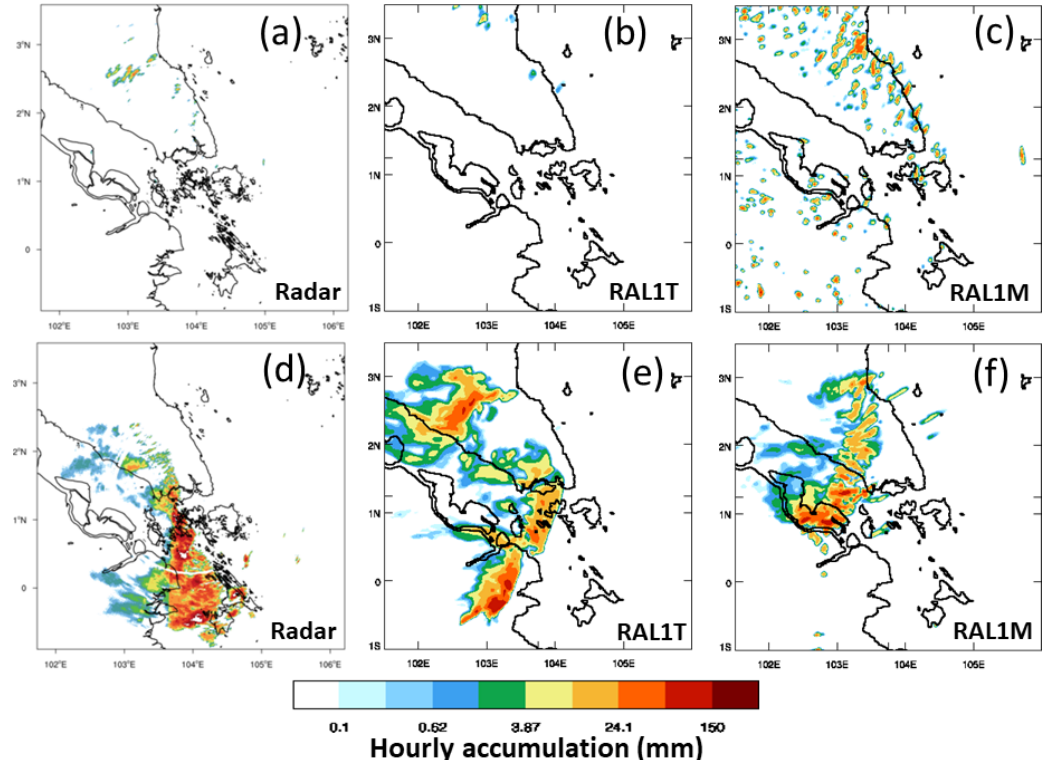
Figure 15. (a) Hourly rainfall accumulation for the Singapore radar at 06:00Z on 18 August 2016. Panel (b) is as panel (a) , but showing the T + 18 RAL1-T forecast initialised at 12:00Z on 17 August 2016 (so valid at the same time as the radar). Panel (c) is as panel (b) , but showing the equivalent RAL1-M imagery. Panels (d–f) are as panels (a–c) , but for the hourly accumulation at 00:00Z on 19 August 2016, which is T + 36 for the same model forecasts as shown in (b) and (c)